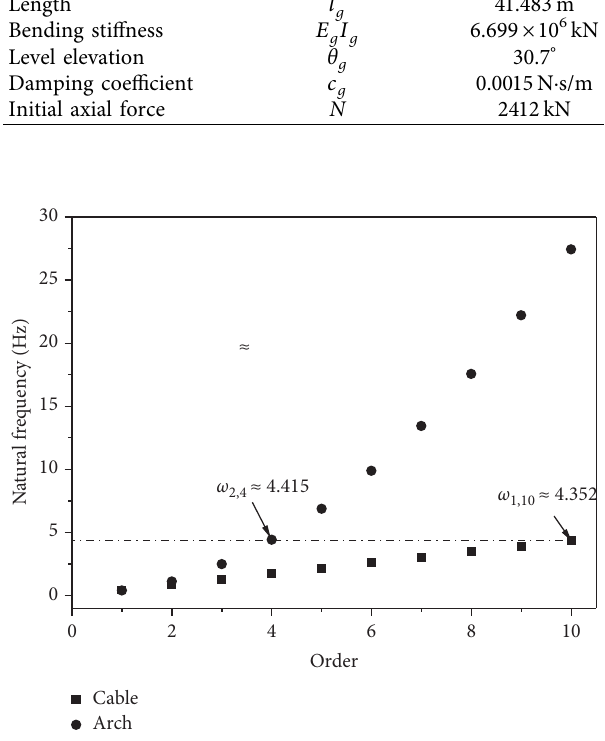
Figure 6: The first ten local and global frequencies of the cable- stayed shallow